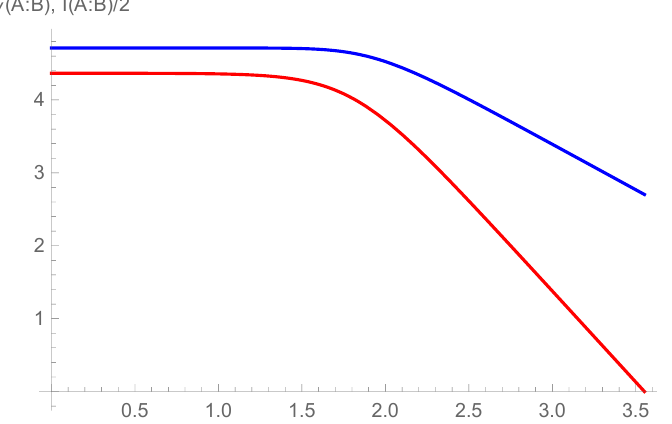
Figure 4 . Half of the mutual information (red) and entanglement wedge cross-section (blue) for spherical shock waves, with t denoting the time in the past of shock insertion. After the red line reaches zero, the entanglement wedge becomes disconnected and the blue line jumps to